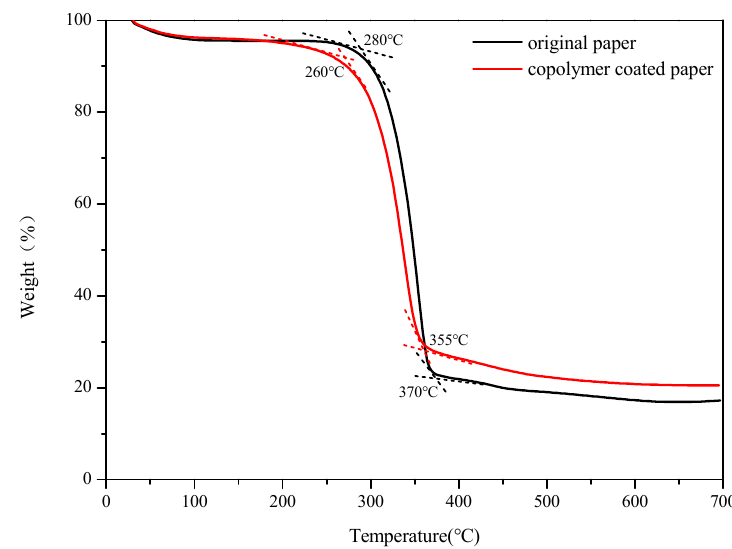
Figure 11. TGA curves of pristine paper and copolymer coated paper.